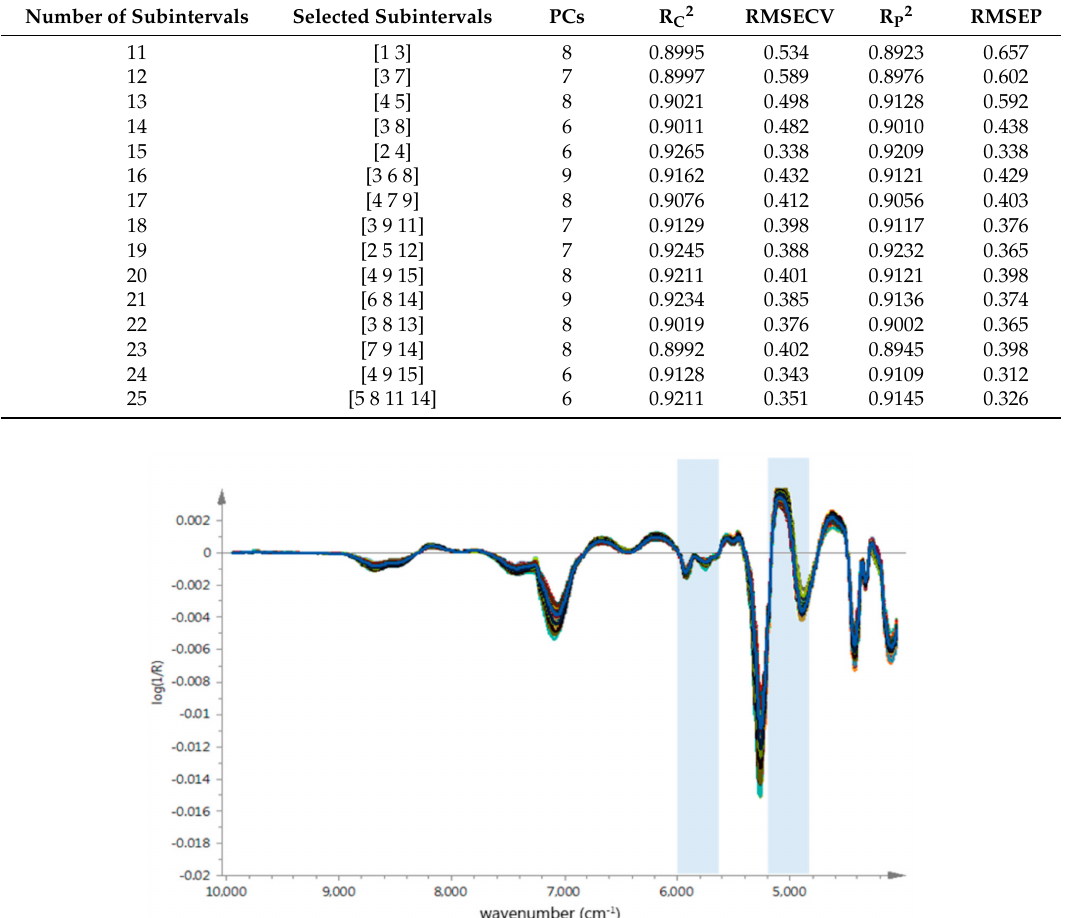
Figure 7. The optimal spectral sub-intervals selected for G. elata samples’ Si-PLS model establishment.